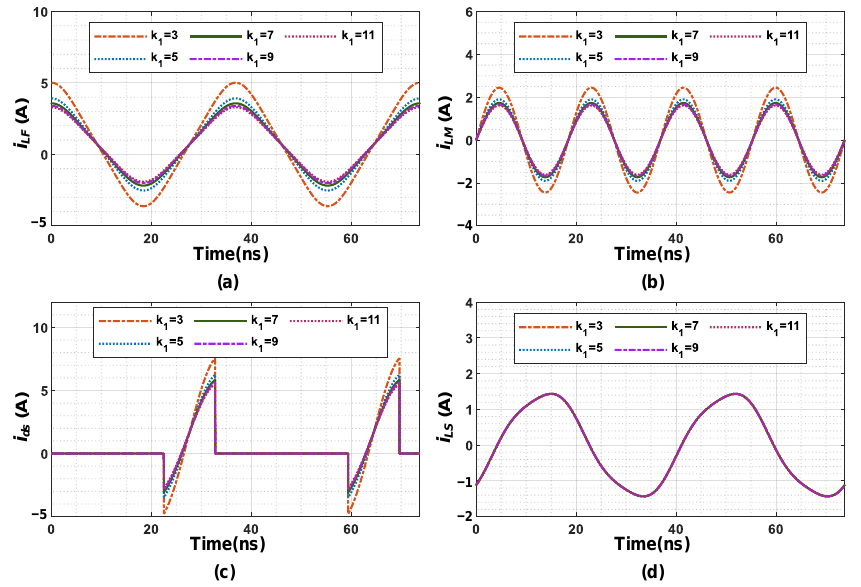
Figure 5. Current waveforms of branch currents under different k 1 values when selecting k 2 = 1.1. ( a ) waveforms of i LF ( t ); ( b ) waveforms of i LM ( t ); ( c ) waveforms of i ds ( t ); ( d ) waveforms of i LS ( t ).